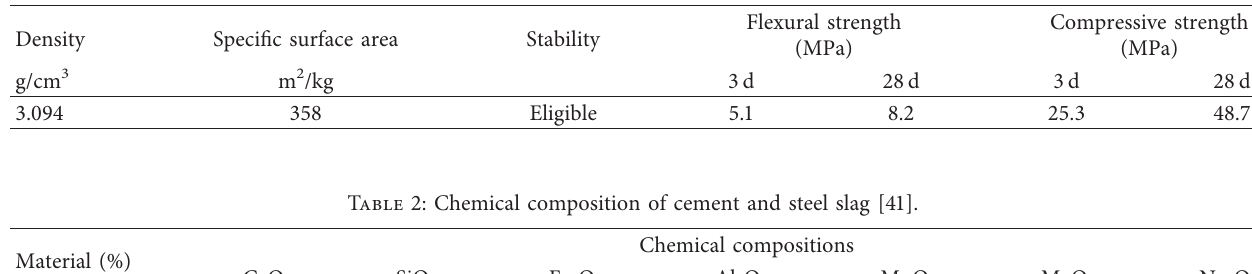
Table 1: Mechanical properties of cement.